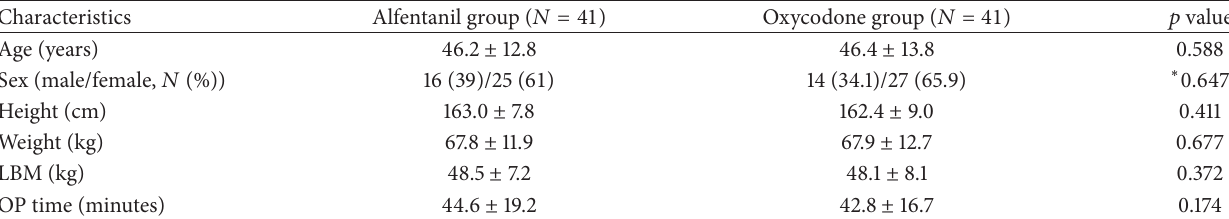
Table 1: Demographic characteristics of patients.